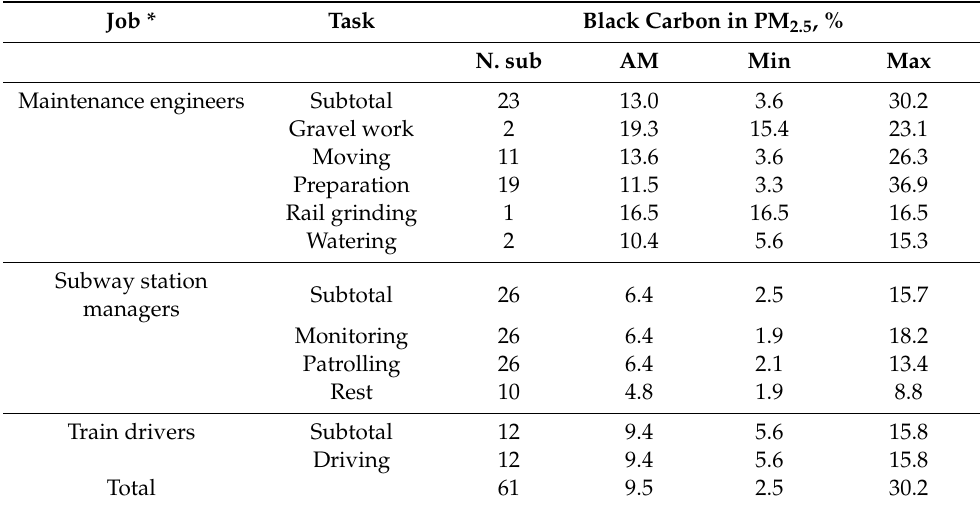
Table 4. Mass concentrations of BC in PM 2.5 according to job and